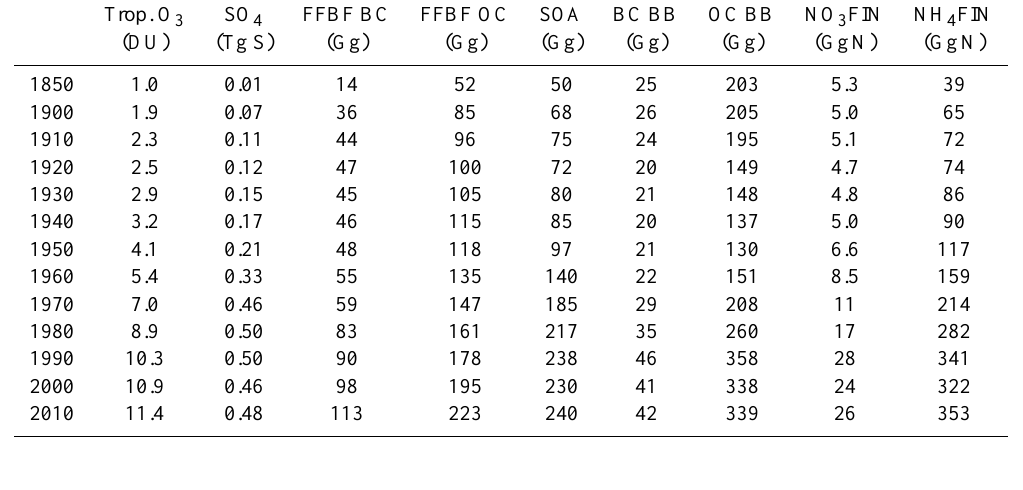
Table 2. The increase in modelled global mean burden for each component since pre-industrial times.